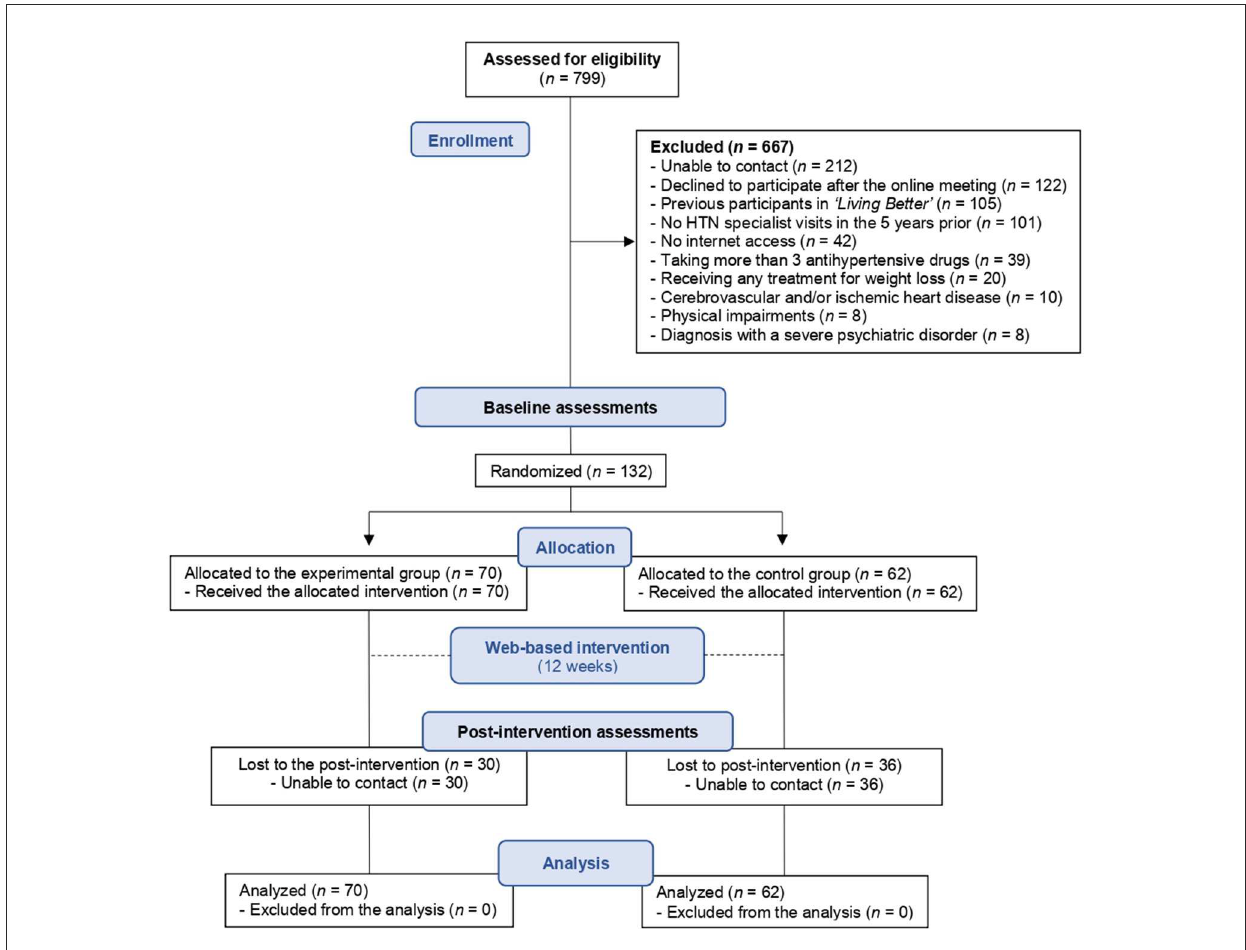
FIGURE1 Progression of the participants through the trial.